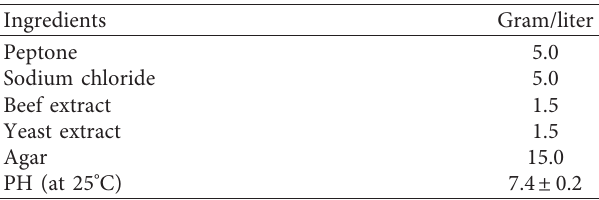
Table 10: Ingredients used in gram/liter in the preparation of M-